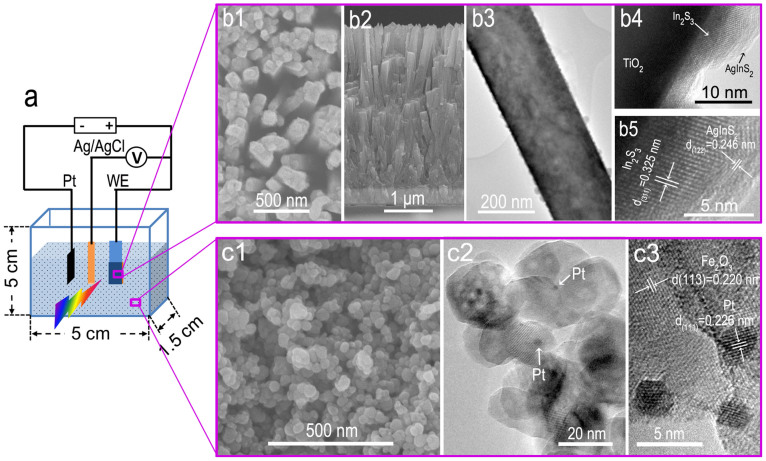
Schematic diagram and morphology and structure characterization.(a) Schematic diagram of PEC cell. (b) FE−SEM (b1 and b2) and TEM (b3–b5) images of TiO2/In2S3/AgInS2 electrode. (c) FE−SEM (c1) and TEM (c2 and c3) images of α−Fe2O3/Pt NPs.